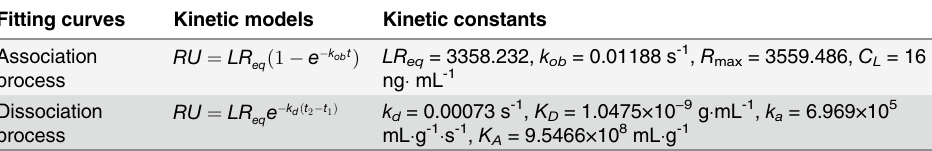
Fig 2. The fitting results obtained from both Newton Iteration algorithm and Marquardt algorithm. The data marked with a triangle is obtained in the average of more than three sets of measurement results in RU, and the fitted curve was marked with a solid line. A. The curve-fitting using the Newton Iteration algorithm with the initial value of 0.0095, B. The curve-fitting using the Newton Iteration algorithm with the initial value of 0.011, C. The curve-fitting using the Marquardt algorithm with the initial value of 0.0095, D. The curve-fitting using the Marquardt algorithm with the initial value of 0.011. doi:10.1371/journal.pone.0132098.g002 Table 1. Kinetic constants of molecular interaction between HBsAg and